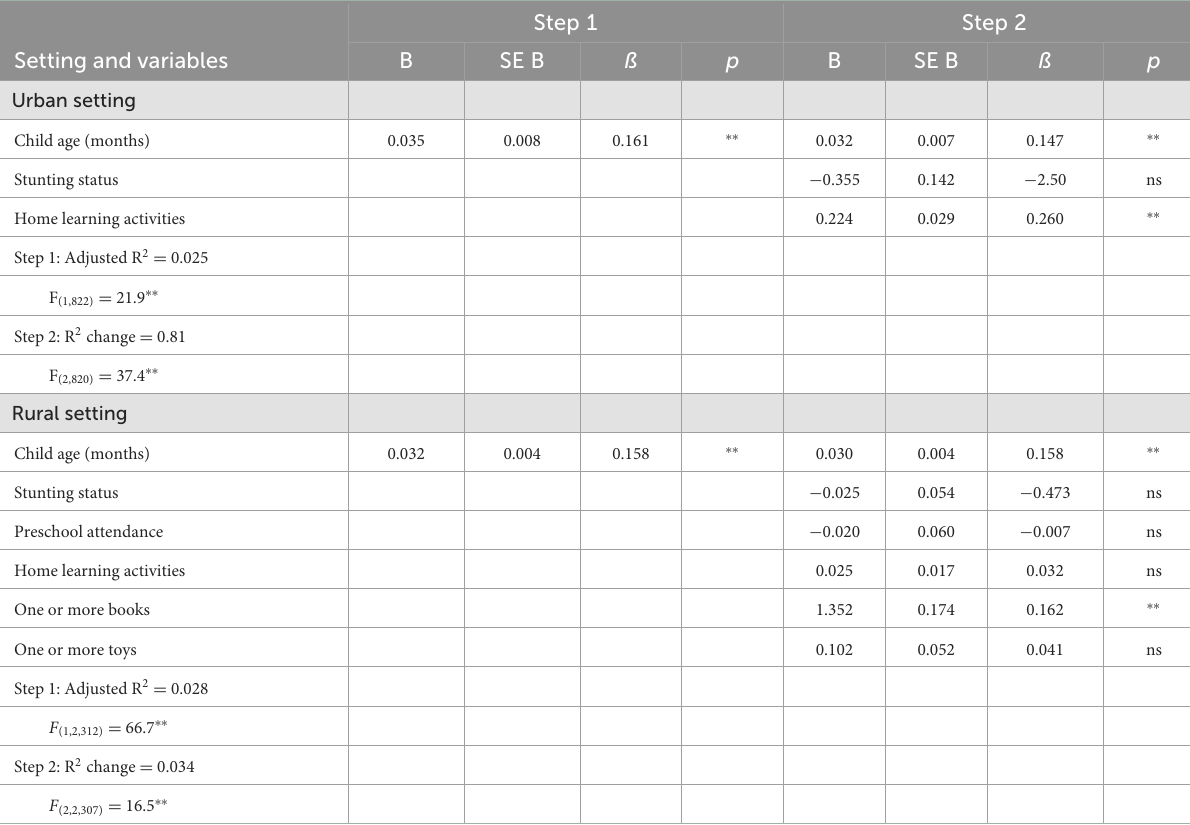
TABLE 9 Summary of findings from hierarchical regression analyses for the relationship between predictor variables and Early Child Development Index scores for 36- to 60-month old children living in urban and rural settings in Côte d’Ivoire. Step 1 Step